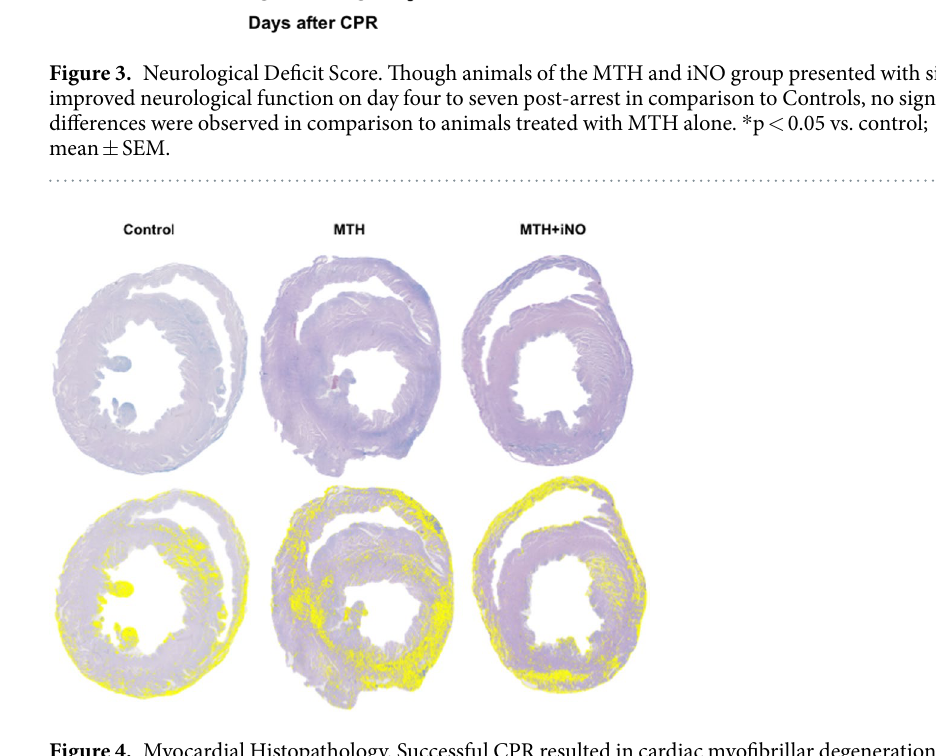
Figure 4. Myocardial Histopathology. Successful CPR resulted in cardiac myofibrillar degeneration, detected by luxol fast blue staining (LFB). Representative photomicrographs of heart cross sections with LFB and nuclear fast red counterstaining on day 7 post ROSC of a control, an iNO and MTH + iNO treated animal. The planimetry analysis with imageJ software discriminates between myofibrillar degeneration (LFB blue staining, yellow markers) and undamaged tissue (nuclear fast red counterstaining, purple). No significant differences were observed between groups (MTH 64 ± 5, MTH + iNO 54 ± 3, Control 57 ± 6, MTH vs Control p = 0.96, MTH + iNO vs Control p = 0.91, MTH vs MTH + iNO p = 0.32).